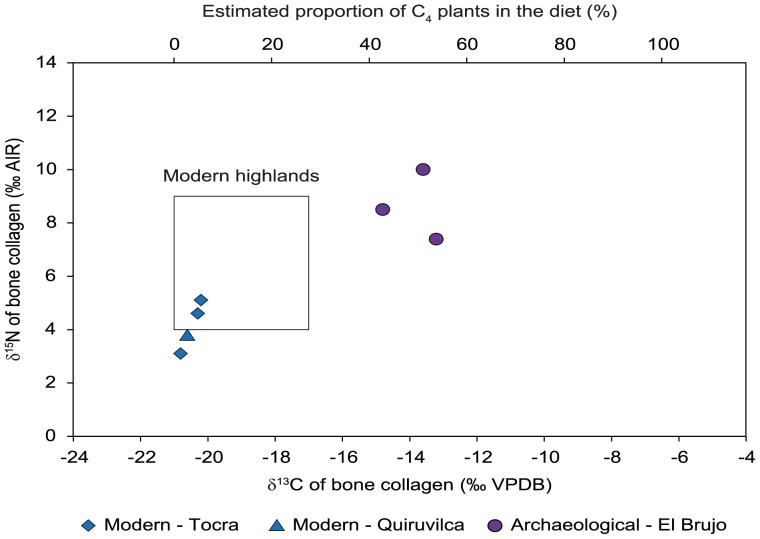
Isotopic composition of bone collagen.Plot of bone collagen δ13C and δ15N values of archaeological (El Brujo) and modern highland domestic camelids from Tocra and Quiruvilca, compared to the range of variations (represented by dashed lines) of modern specimens, compiled by Thornton et al [34]. The proportion of C4 in the diet was reconstructed using mean estimated pre-industrial δ13C values of pure-C3 and pure-C4 feeders.